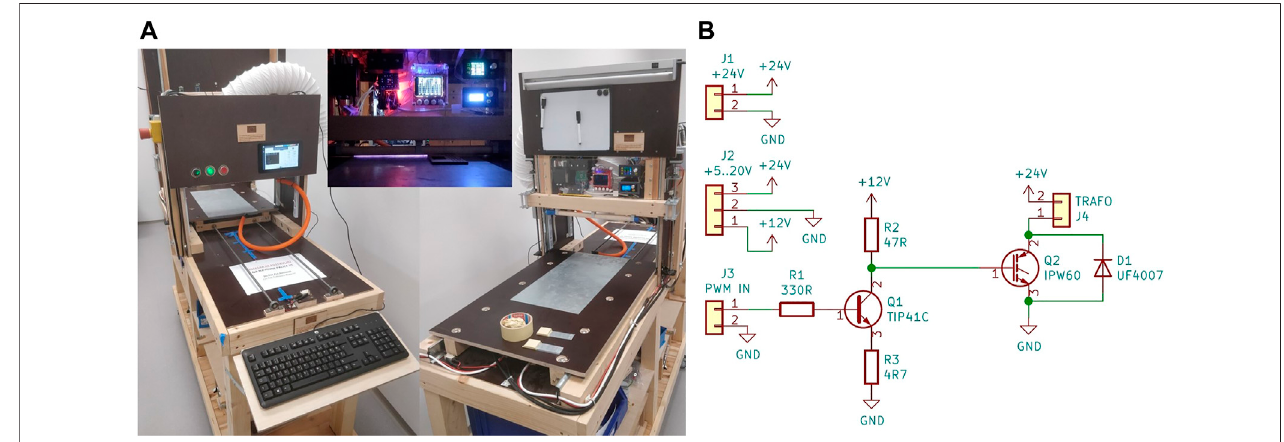
FIGURE 1 | Overall plasma setup (A) and electrical circuitry of the included HV power supply (B) .